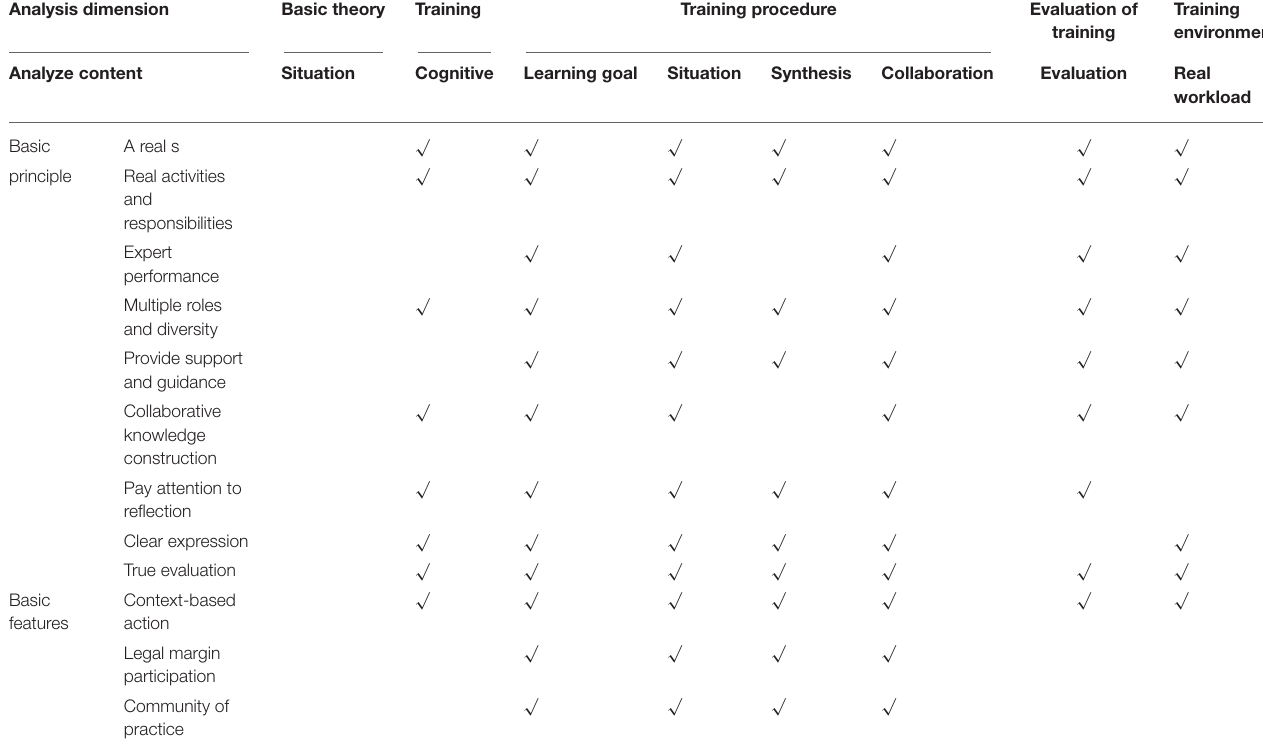
TABLE 1 | The relationship between the situated cognition theory and the REST program.